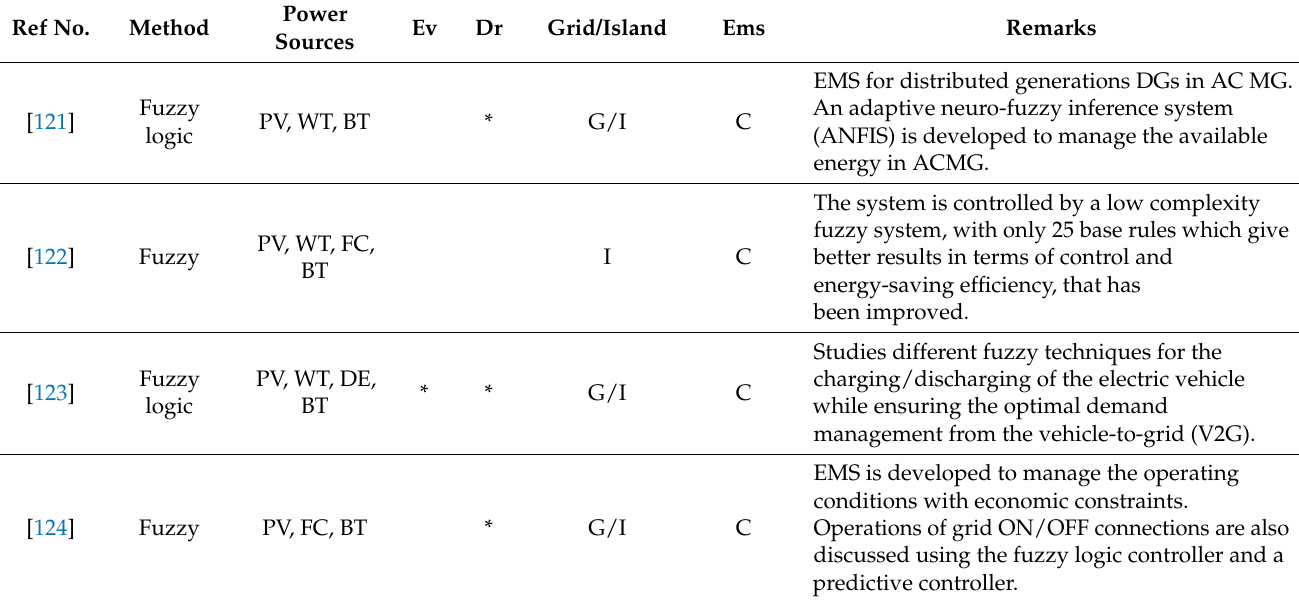
Table 7. A review on fuzzy and ANN-based applications in